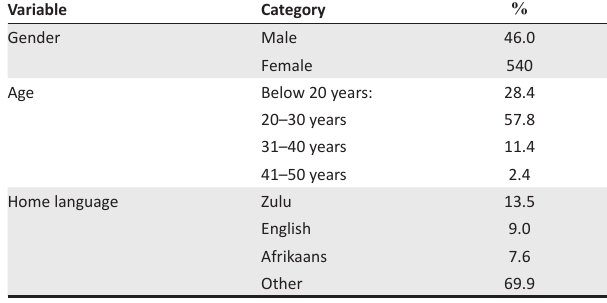
TABLE 2: Demographics of respondents.